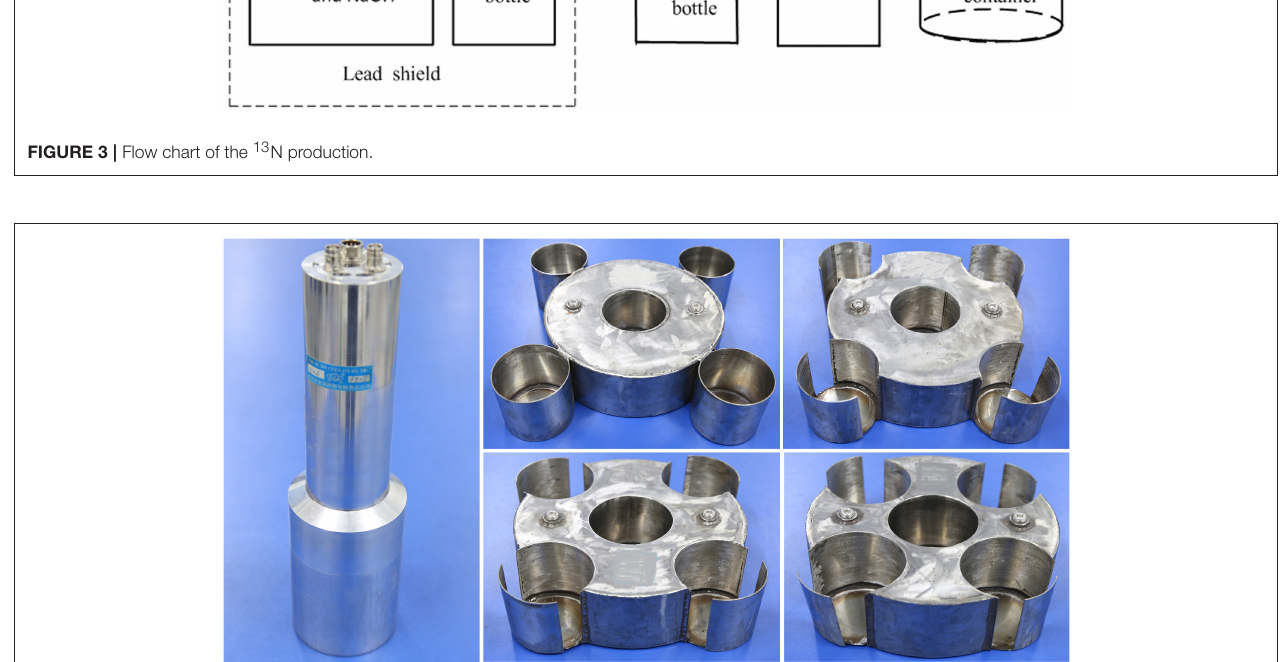
FIGURE 4 | Detector and sampling container used in